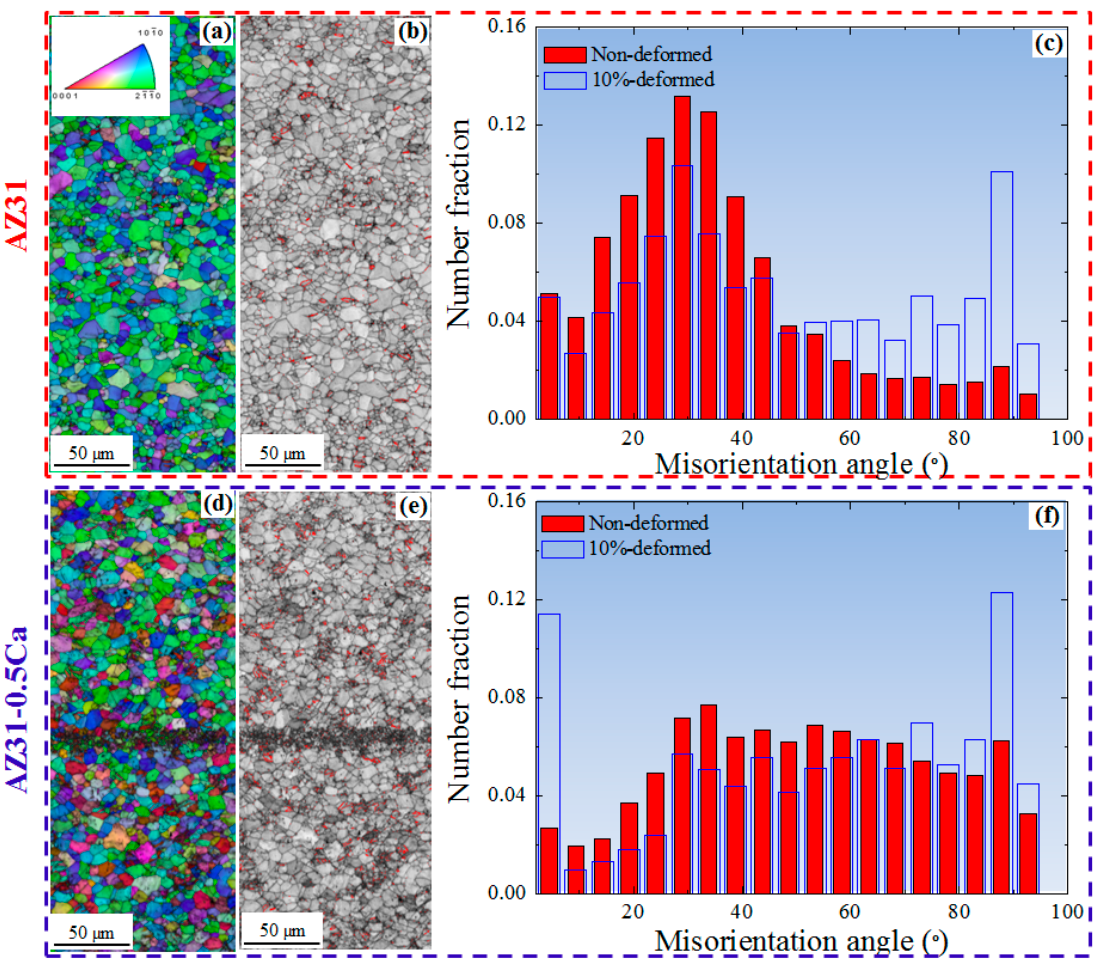
Figure 6. ( a , d ) ND inverse pole figure maps; ( b , e ) image quality maps; and ( c , f ) misorientation angle distributions of the 10%-deformed AZ31 and AZ31-0.5Ca alloy, respectively. For comparison, the misorientation angle distributions of the initial samples (non-deformed) were also included. In addition, the tension twin boundaries (~86°) were shown by the red lines in the image quality maps ( b , e ).